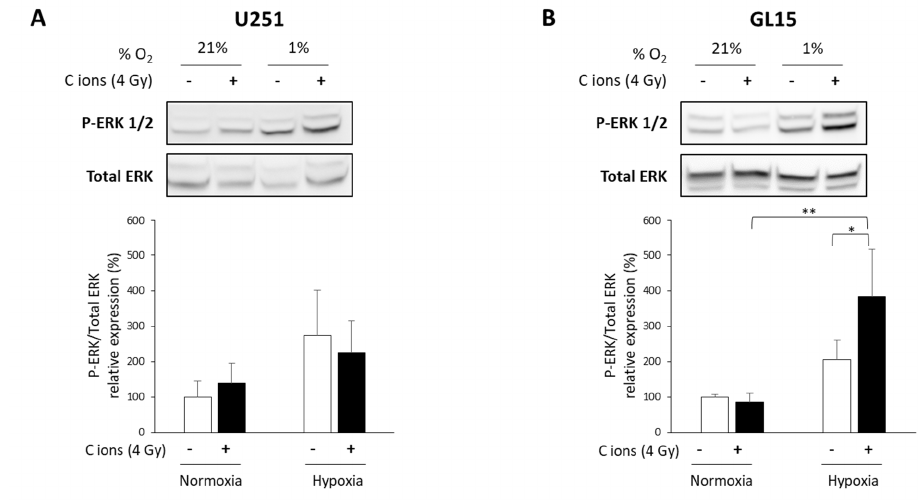
indicate that EPOR knockdown radiosensitizes U251 cells to CIRT by increasing apoptosis (subG1 phase) consecutive to an increase in DNA damage (G2 / M arrest).